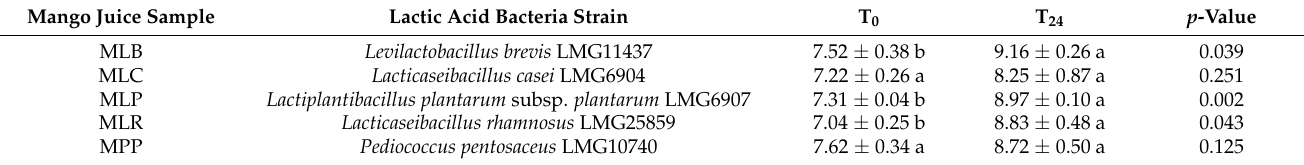
Table 1. Viable cell counts (log CFU/mL) of lactic acid bacteria in mango juice after 24 h fermentation. Mango Juice Sample Lactic Acid Bacteria